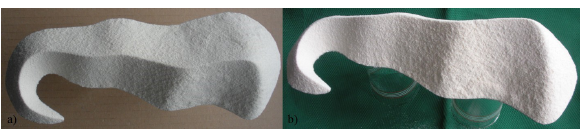
Figure 4: The actual laboratory embankment model: a) top view;